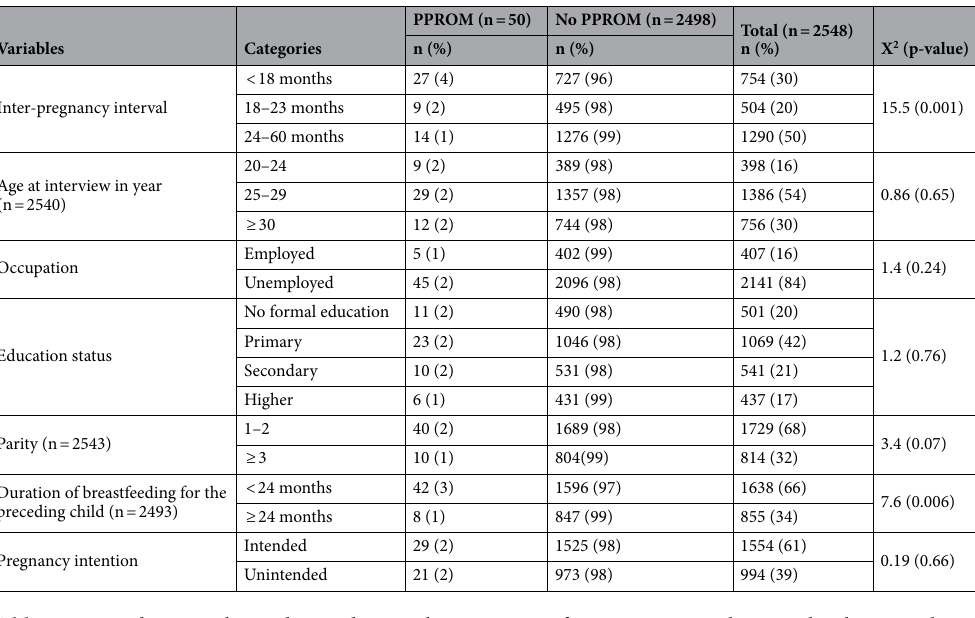
Table 1. Socio-demographic and reproductive characteristics of participants in urban South Ethiopia, July 2019—September 2020. Data were missed for age, parity and duration of breastfeeding for the preceding child, all were from women without PPROM.